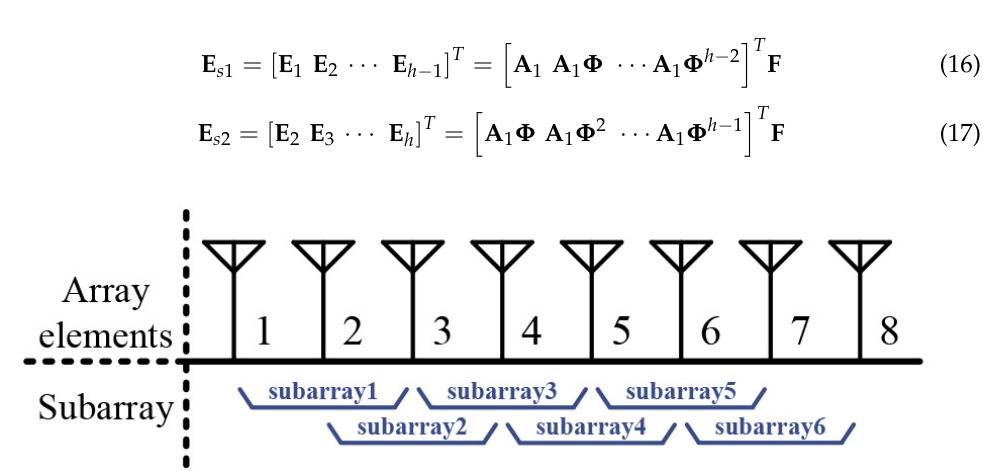
Figure 3. Subarray structure for multiple invariances (MI)-ESPRIT algorithm ( M = 8, h = 6, z =